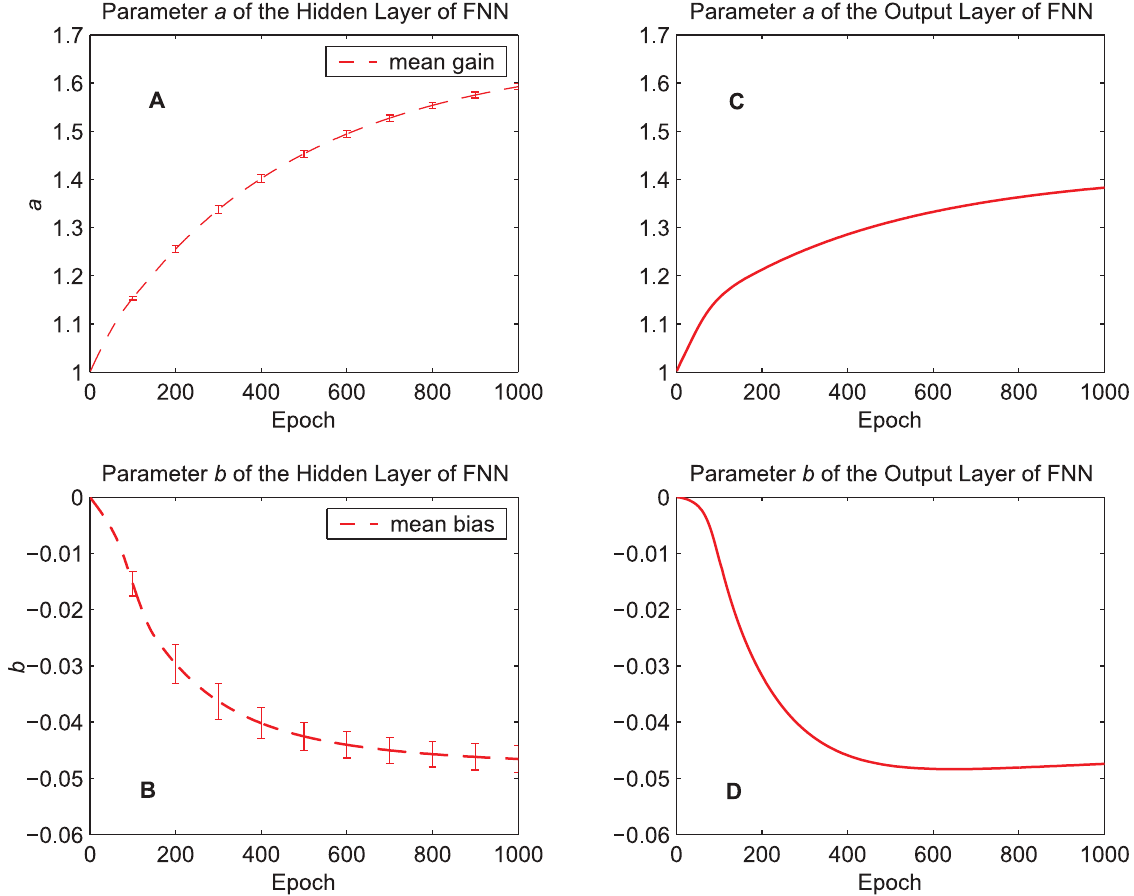
Figure 8. Evolution of the parameters of the activation functions in the FNN. The training data set ‘‘MG’’ is used. (A) Mean of the gain parameter a of the five hidden neurons. (B) Mean of the bias parameter b of the five hidden neurons. (C) The gain parameter a of the output neuron. (D) The bias parameter b of the output neuron.